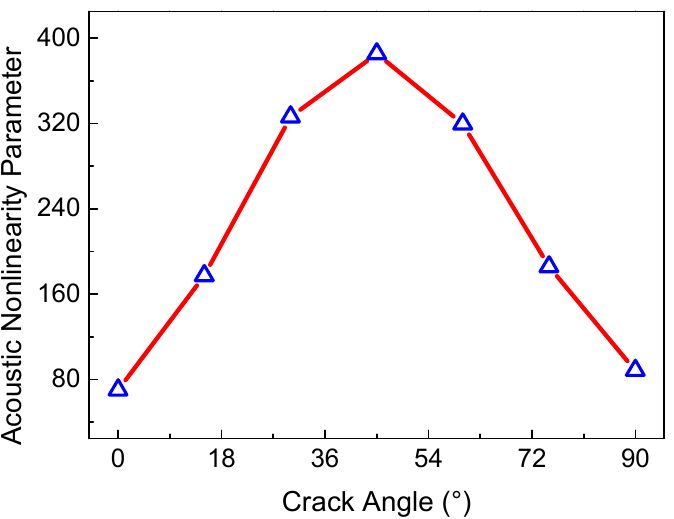
Figure 10. ANP versus crack angle ( c = 0.009375, f R = 6 MHz, μ = 0.3, L 1 = 40 mm, L 2 = 4 mm, L 3 = 36 mm).